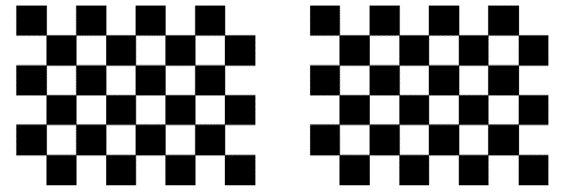
Figure 2. Tests used for the calibration process